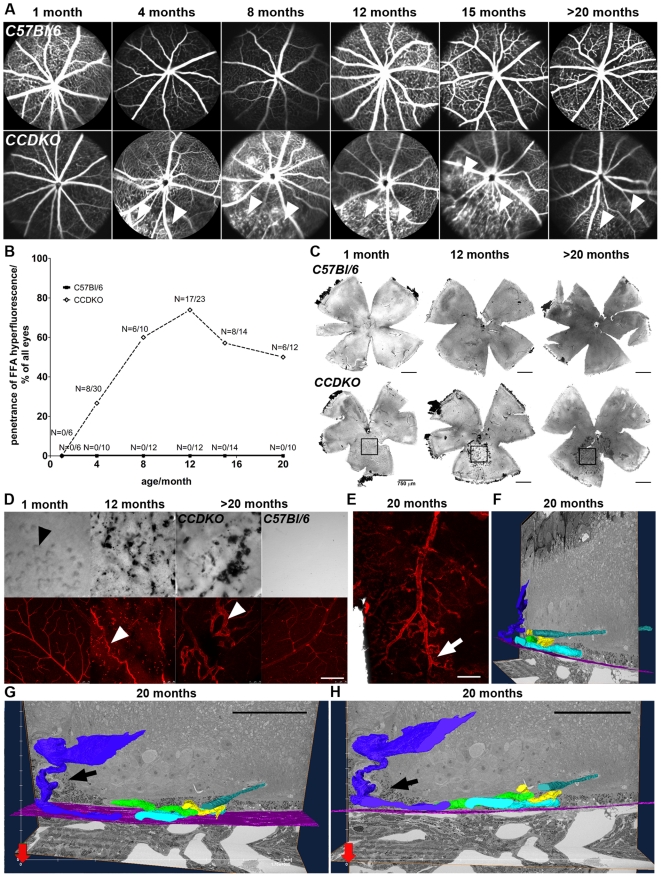
Vascular lesions in CCDKO mice develop secondarily to the retinal degeneration and show similarities to retinal telangiectasia rather than choroidal neovascularisation.(A) Late phase fluorescein angiography images of CCDKO mice and age-matched wildtype mice between 1 month and over 20 months of age reveals a late phase (∼7 min post i.p. injection) hyperfluorescence of fluorescein (white arrowheads) secondary to the focal early onset, inferior retinal degeneration. (B) Quantification of the penetrance (%) of late stage hyperfluorescence in CCDKO mice at different ages in comparison to C57Bl/6 mice. The number of animals (N) analysed per age group and genotype are shown in the graph (N = eyes with late FFA hyperfluorescence/total number of imaged eyes). (C) DIC bright field images of retinal flat mount preparations of CCDKO and age-matched wildtype controls at 1 months, 12 months and 20 months, scale bar: 750 µm. (D) Magnified DIC bright field images and corresponding immunohistochemistry staining for the vascular marker isolectin B4 (TRITC-lectin-B4, red) taken from the affected inferior degenerate areas (black squares in (C)).At 1 month, early separate grey spots (5D, black arrowhead) were observed inferior to the optic disc, which later grow bigger, become confluent and involve pigmented cell attached to the focal inferior retinal lesion. Lectin-positive vessels within the area of degeneration show vascular anomalies secondary to the retinal degeneration, including vascular tortuosity (5D, white arrowhead, at 12 months) and dilation of retinal capillaries (5D, white arrowhead, at 20 months).Scale 150 µm. (E) Overlay of a bright field and immunohistochemistry image taken from the apical side of a lectin-stained RPE/choroidal flat mount from a CCDKO mouse at 20 months of age. The retinal vasculature within the degenerate area (white arrow) was closely attached to the underlying apical side of the RPE. Scale: 100 µm. (F–H): Different views of a three dimensional reconstruction from a tissue block from the centre of an inferior retinal lesion of a CCDKO mouse at 20 months of age using serial block-face scanning electron microscopy with a Gatan 3-View system. Connected vascular lumens are labeled by an identical color, while the location of Bruch's membrane in each ultrathin section is outlined by a pink line. Retinal vessels collapse onto the RPE and induce a migratory response of RPE cells to grow along these vessels into the retina (black arrows). Retinal vessels grow underneath the RPE and become positioned in close vicinity to Bruch's membrane within a RPE/vascular complex, but they never have been observed to grow through Bruch's membrane (Representative 3D reconstruction images from a tissue block with the dimensions; x-axis 176.42 µm, y-axis 176.42 µm, z-axis: 39.9 µm, Scale (G&H): 50 µm.